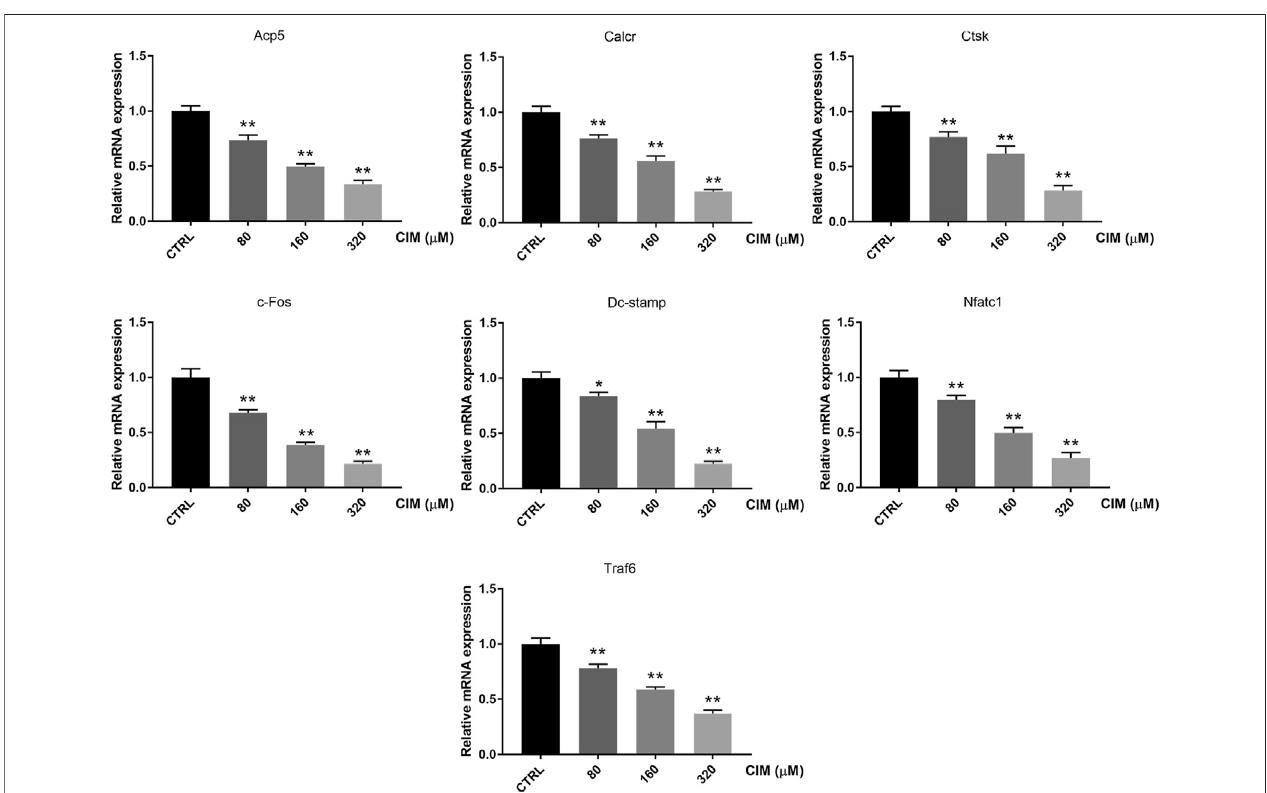
FIGURE 3 | CIM dose-dependently represses the expression of osteoclast marker genes, including c-Fos, Nfatc1, Acp5, Calcr, Ctsk, Dc-stamp and Traf6, in RANKL-stimulated osteoclasts. These genes were quanti fi ed by qRT – PCR and normalized to the level of the housekeeping Gapdh. (*: p < 0.05; **: p < 0.01 compared with the control